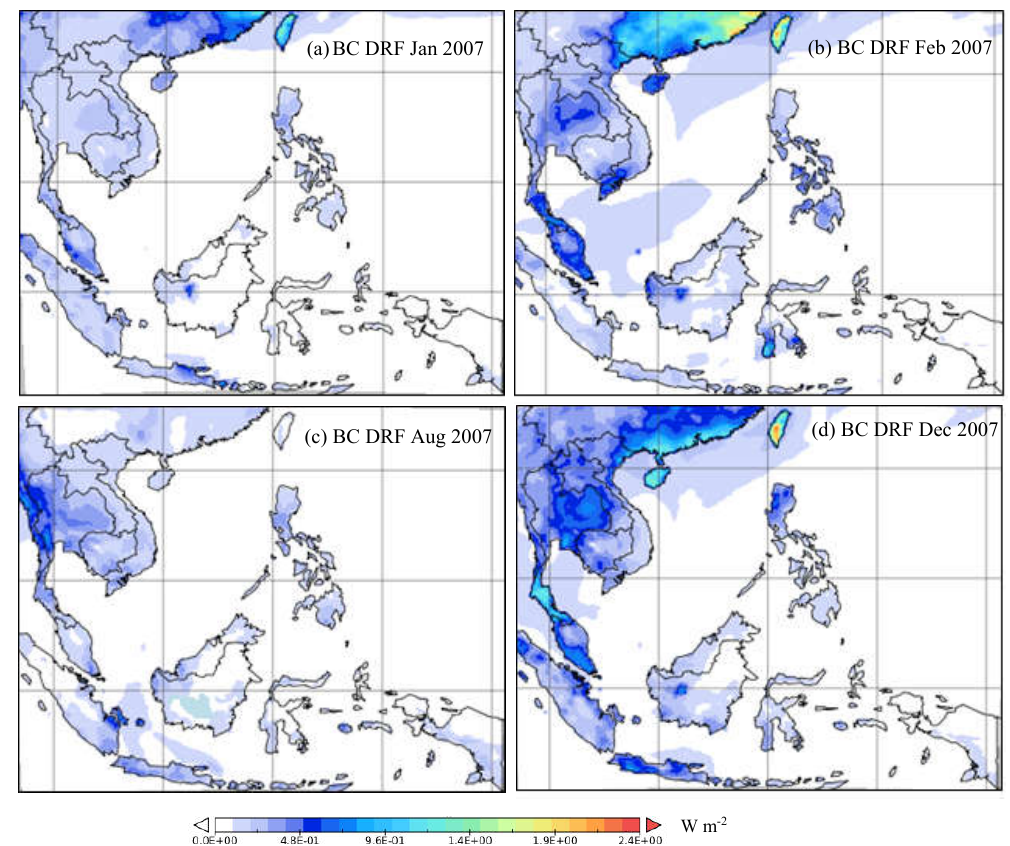
Figure 1. Spatial distribution of monthly average BC direct radiative forcing for the selected months,